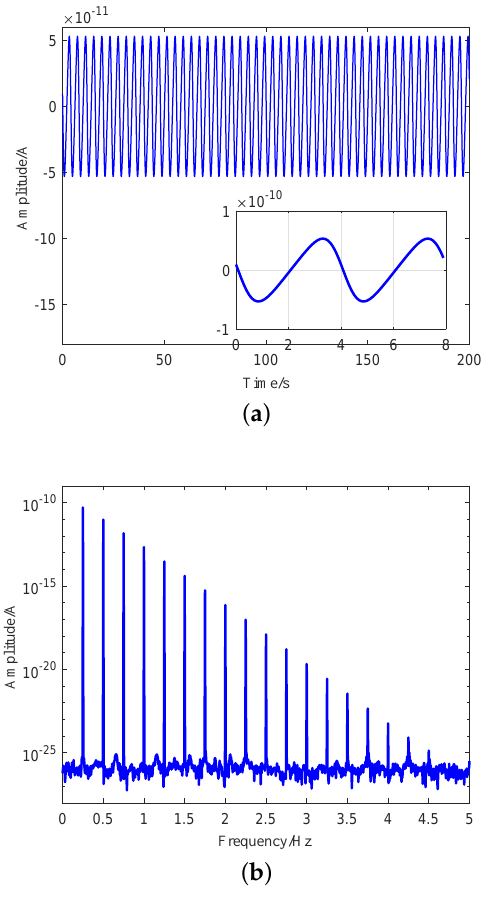
Figure 3. Output signal of accelerometer A 1 . ( a ) Time-domain waveform of accelerometer A 1 . ( b ) Spectrum of accelerometer A 1